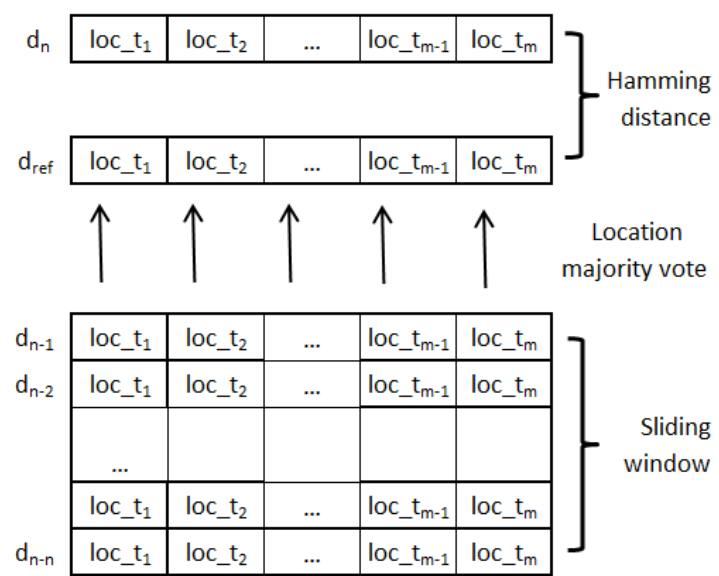
Figure 4. Overview of the MoBaDDD algorithm. Each day is divided into m time intervals. The current day’s ( d n ) reference day d ref is constructed determining each time interval’s location by a majority vote over the preceding n days. Finally, the Hamming distance is calculated between d n and d ref .